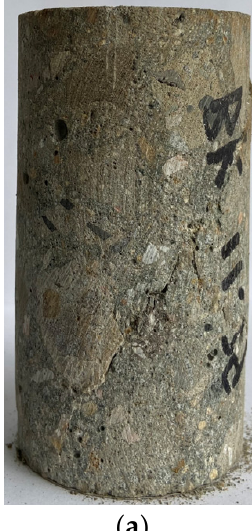
Figure 11. Comparison of simulated and experimental stress–strain curves (RAC20, confining pres- sure 2.5 MPa).